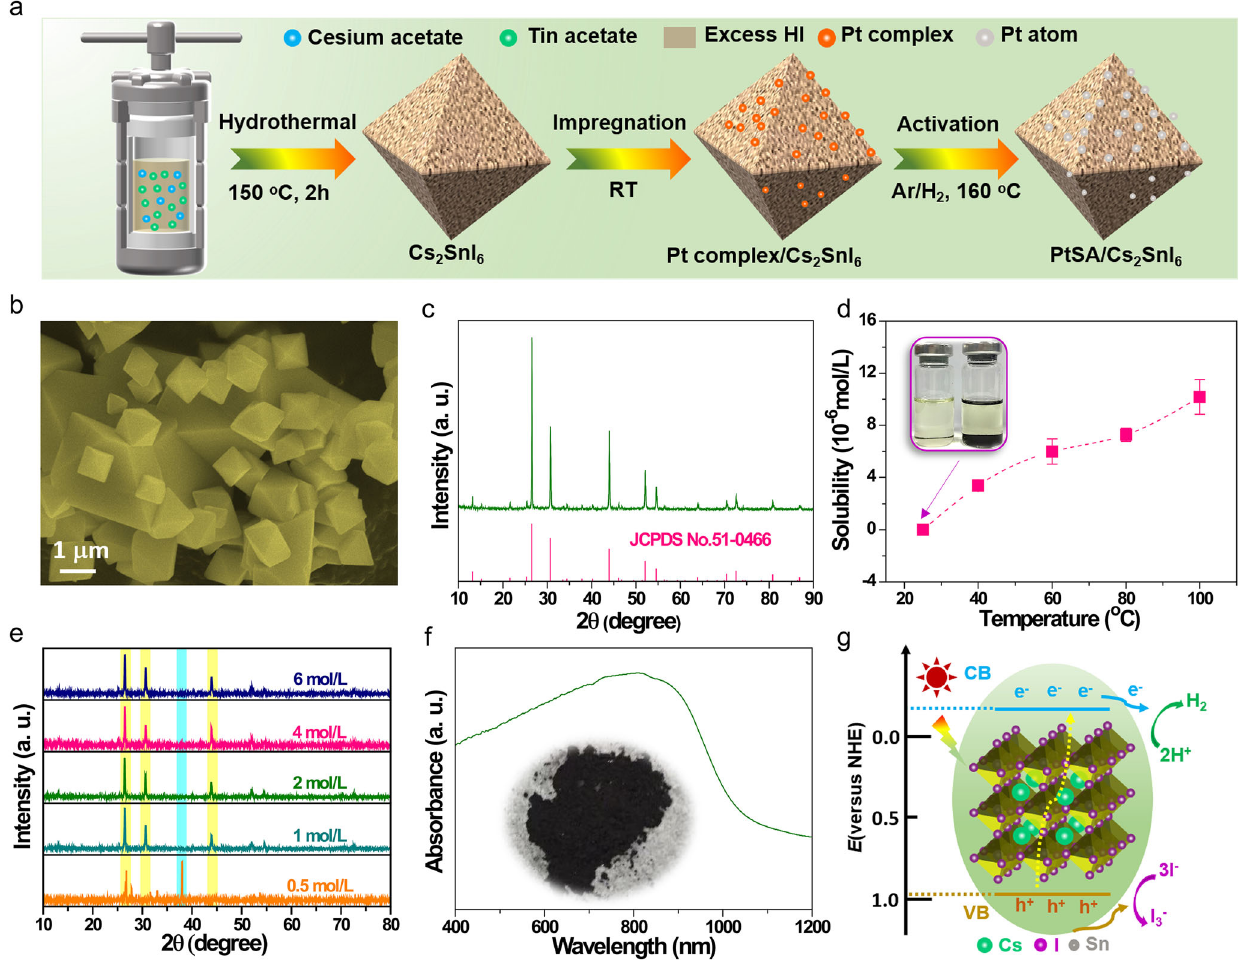
Fig. 1 Energy band structure of Cs 2 SnI 6 and its stability in aqueous HI solution system. a Schematic diagram of preparation process for the PtSA/Cs 2 SnI 6 catalyst. b SEM image and c PXRD pattern of Cs 2 SnI 6 . d Solubility of Cs 2 SnI 6 in aqueous HI solution at different temperature. The inset shows the photograph of the 6 M HI aqueous solution with and without Cs 2 SnI 6 powder at 25 °C. e PXRD patterns of precipitates for Cs 2 SnI 6 powder in aqueous HI solution with various concentrations. f UV – visible absorption spectrum of Cs 2 SnI 6 powder. The inset is the photograph of the Cs 2 SnI 6 . g Schematic energy band diagram of the Cs 2 SnI 6 , charge generation and charge transfer process over the Cs 2 SnI 6 under visible-light